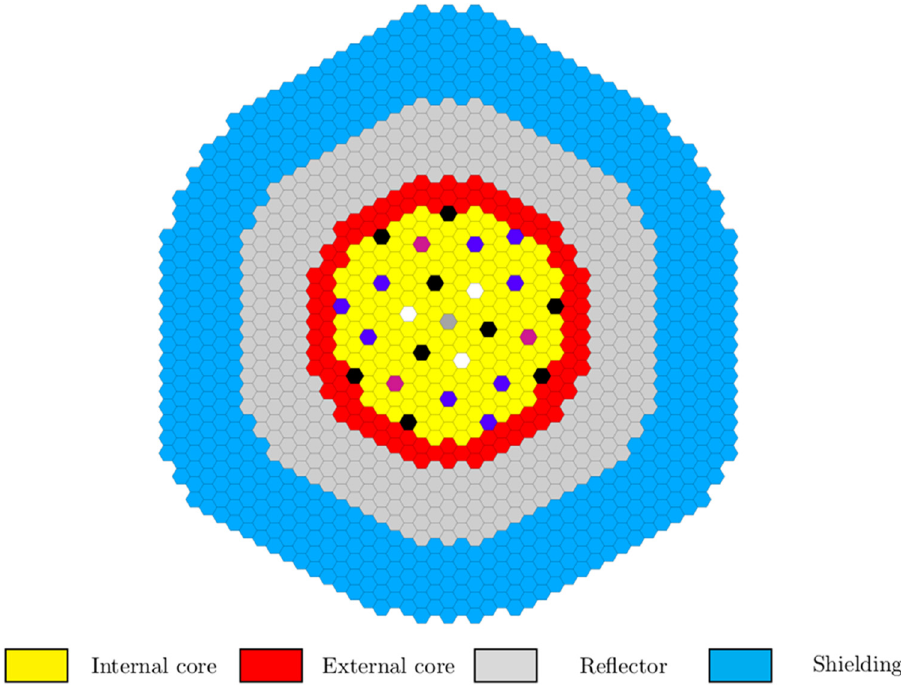
Fig. 2. Radial description of the ASTRID-like core studied in this benchmark (assembly pitch is 17.17 cm).